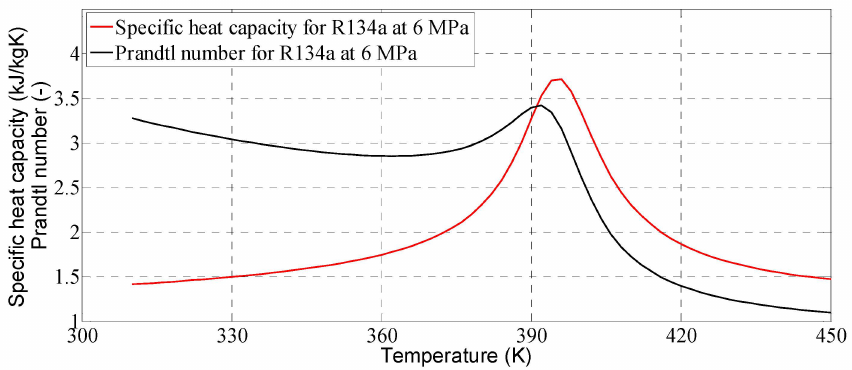
Figure 2. Variation of specific heat capacity and Prandtl number with